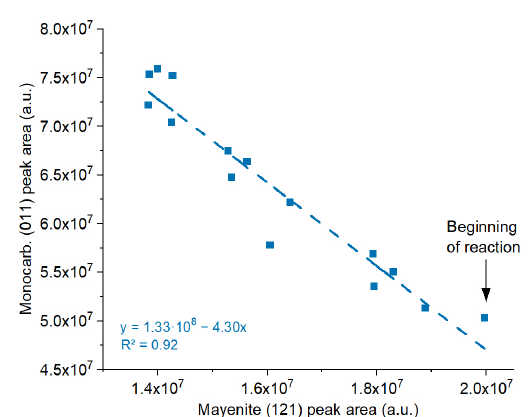
Figure 6. Monocarboaluminate (011) versus mayenite (121) peak areas. The average crystallite sizes (D) of monocarboaluminate (011), katoite (121), and mayenite (121) were calculated using the Scherrer equation, , where is the X-ray wavelength, is the peak width at half-maximum, and D = 0.9 λ / β cos θ λ is the Bragg diffraction angle. The peak deconvolution used β a Lorentz function, and the peak width was assumed to be θ simply due to size effects